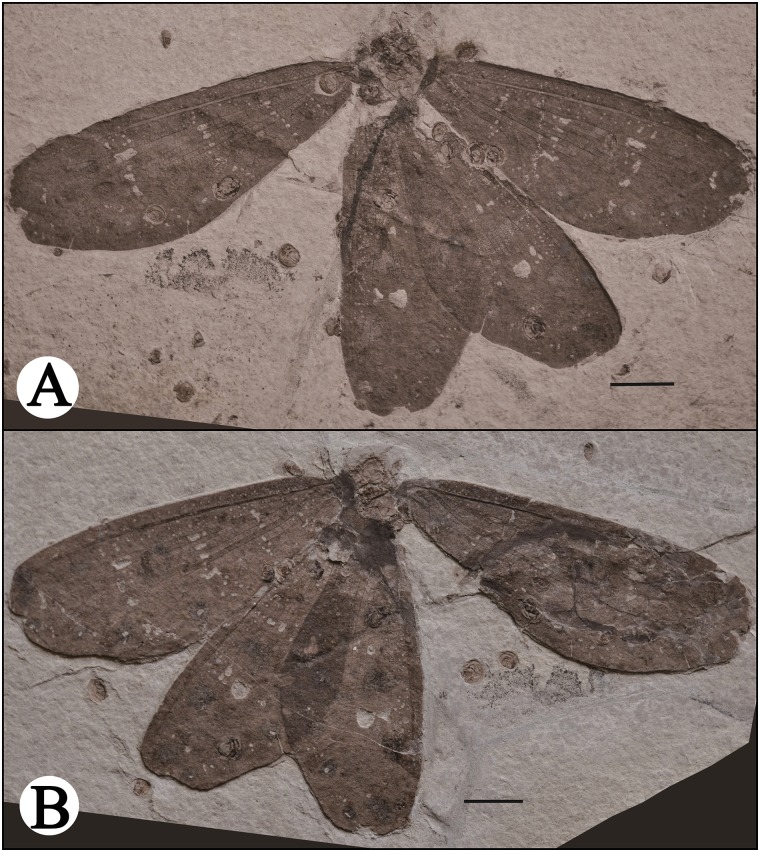

Ulrikezza aspoeckae gen. et sp. novHolotype: CNU-NEU-NN2015001PC. A. part, B. counterpart; Scale bar = 10 mm.